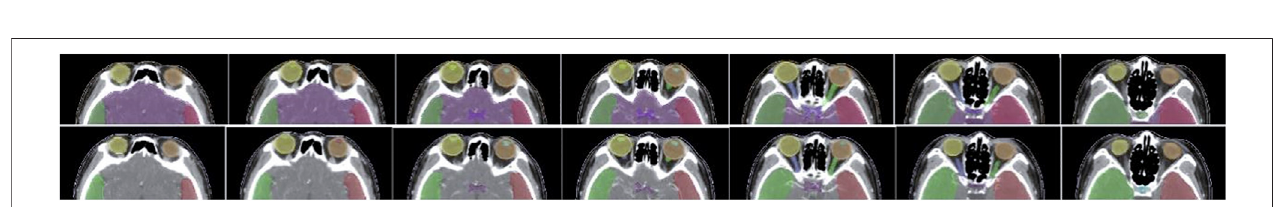
FIGURE 7 | Comparison of segmentation of small organs using EB-Net-based auto-contouring (upper) with the physician manual delineation (lower) .